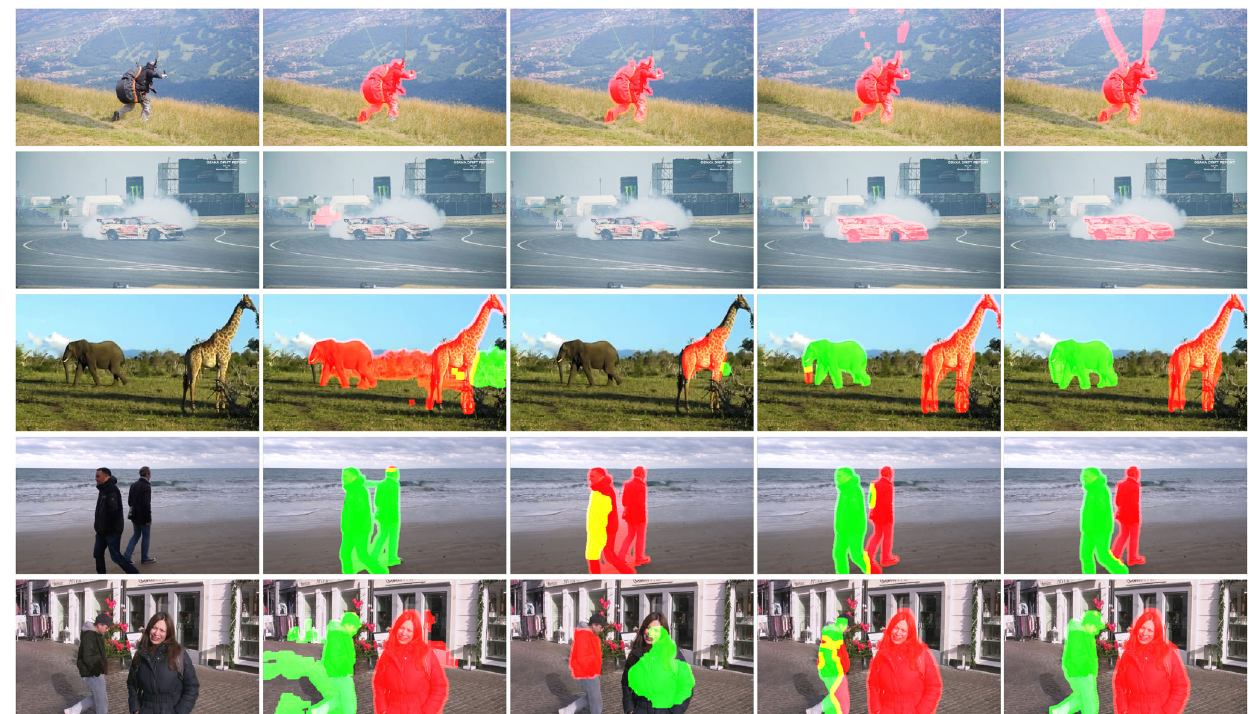
Fig. 7 Visual comparison of different segmentation approaches. Left to right: original, SeamSeg [71], ObjectFlow [72], OSVOS [8],